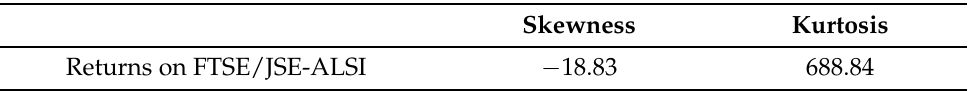
Table 2. Descriptive statistics for intra-day returns with reported skewness and kurtosis of logarithmic returns on